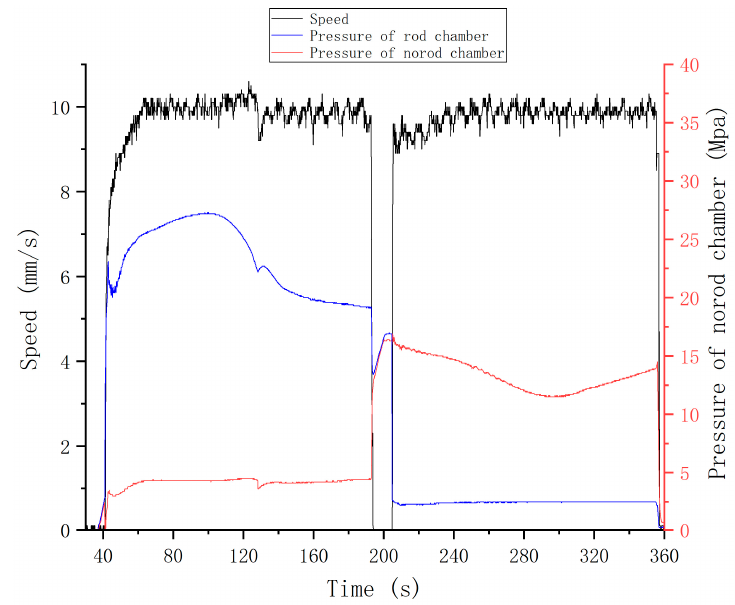
Figure 24. Movement schematic of boom section 4.